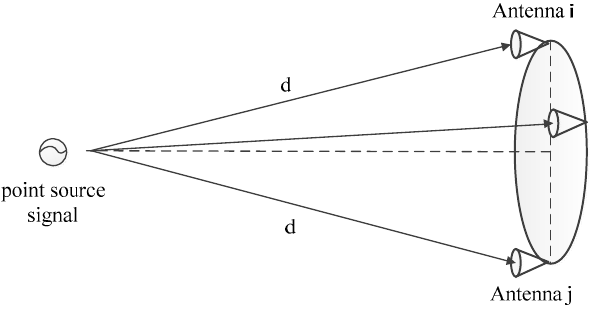
Figure 4. Phase correction diagram.